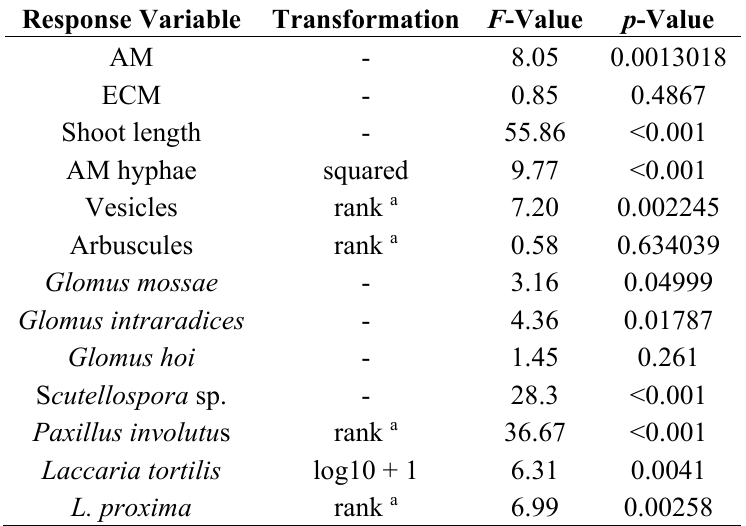
Table 3. ANOVA table of the LMMs showing the fixed effect of former land use type (C-, G-, P- and S-soil) on the different response variables while accounting for clone type as a random effect; degrees of freedom ( df ): three between groups and 18 within groups.